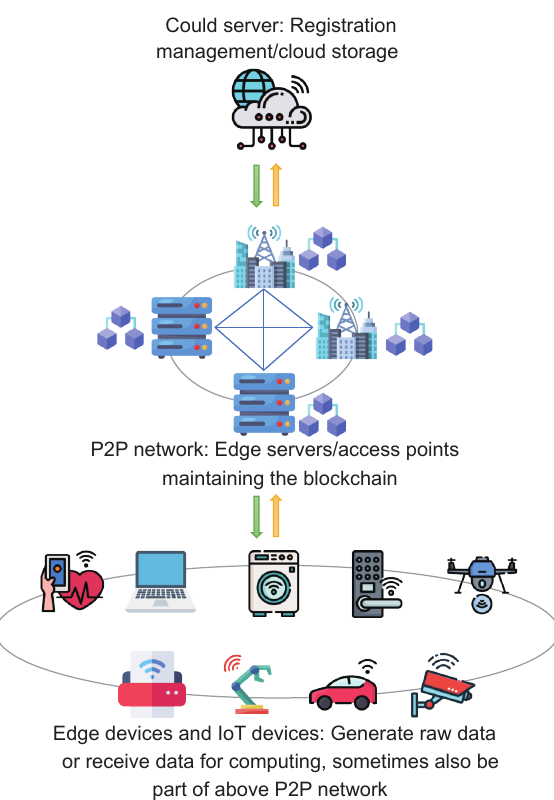
Fig. 7 General architecture of blockchain-enabled IoT and edge computing